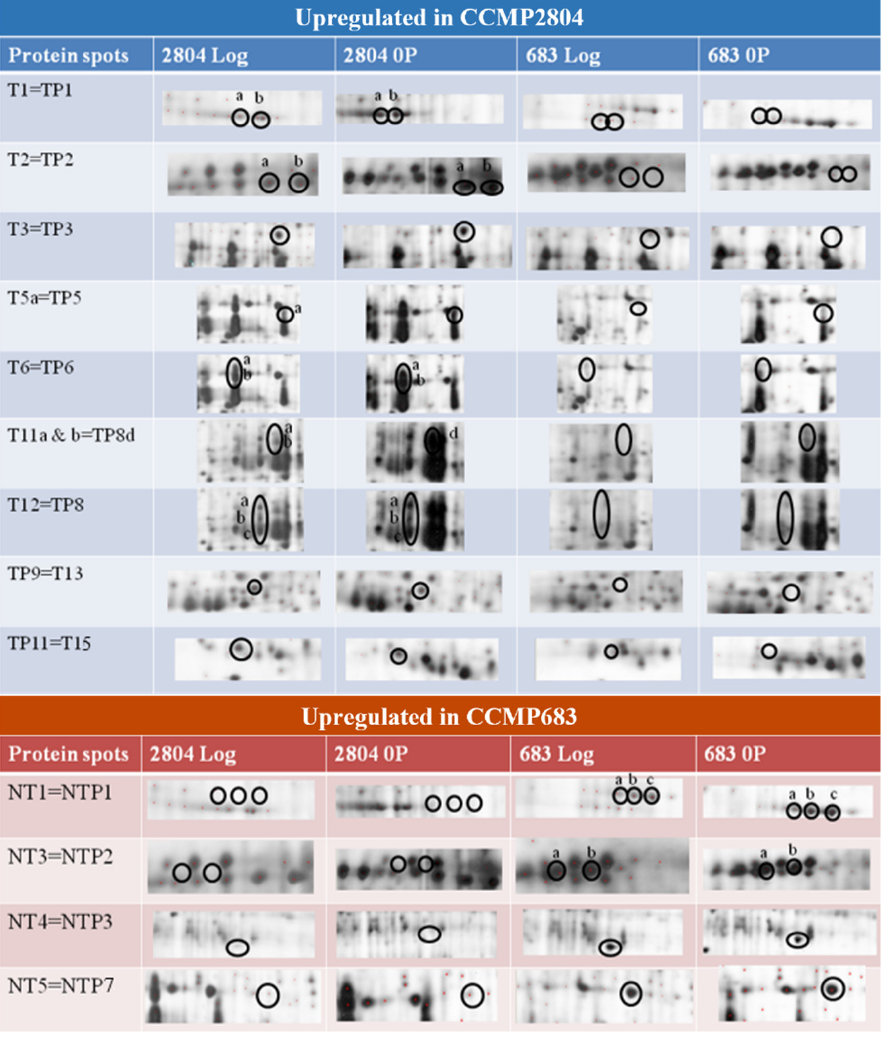
Figure 4. Upregulated protein spots that were commonly found during log and under 0P in the 2-DE profiles of CCMP2804 or CCMP683 when compared to each other.